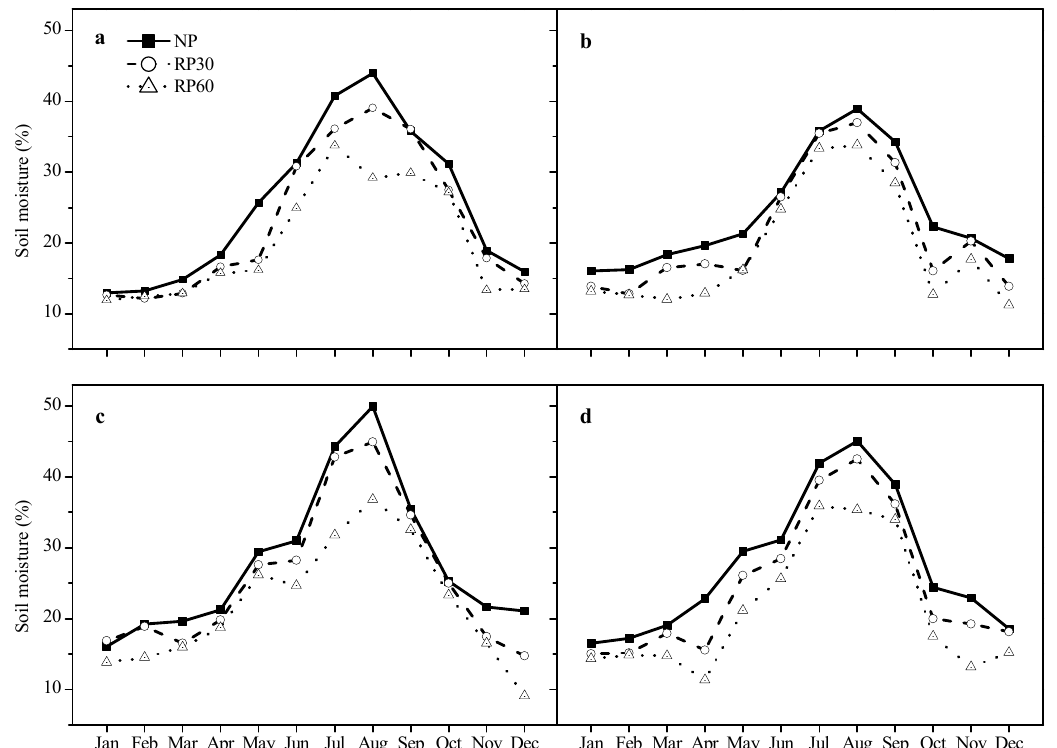
Figure 1. Seasonal dynamics of soil moisture under different precipitation treatments from January to December 2018 in the control ( a ), lightly thinned ( b ), moderately thinned ( c ), and highly thinned ( d ) L. principis - rupprechtii plantations. NP, natural precipitation; RP30, 30% reduced precipitation; RP60, 60% reduced precipitation.